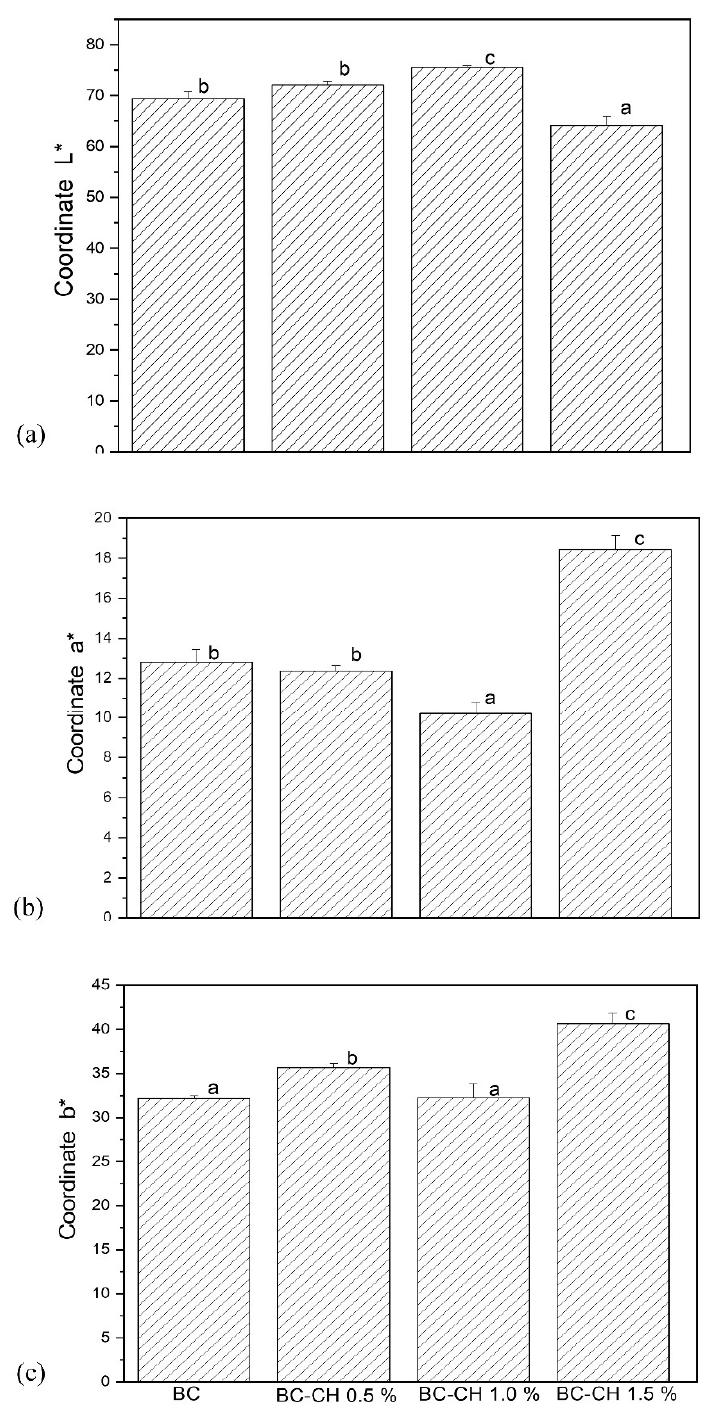
Figure 6. Parameters of colors: ( a ) L* (luminosity, 0 black to 100 white), ( b ) a* ( − green to +red), and ( c ) b* ( − blue to +yellow) of BC and BC-CH films coated with various concentrations of chitosan. Average ± standard deviation. Letters (a, b, c) indicate significant differences ( p < 0.05) between treatments.